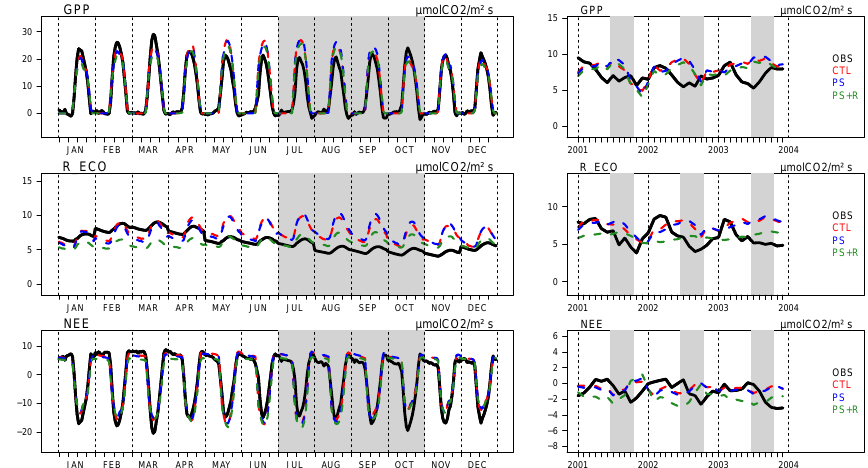
Figure 6. Observed and simulated GPP, R ECO and NEE at k83. Left panels show the diurnal cycle for each month averaged over 3 years (2001–2003); and right panels, monthly mean time series for 2001–2003. Gray shaded areas indicate dry seasons (defined as periods with precipitation less than 100mmmonth − 1